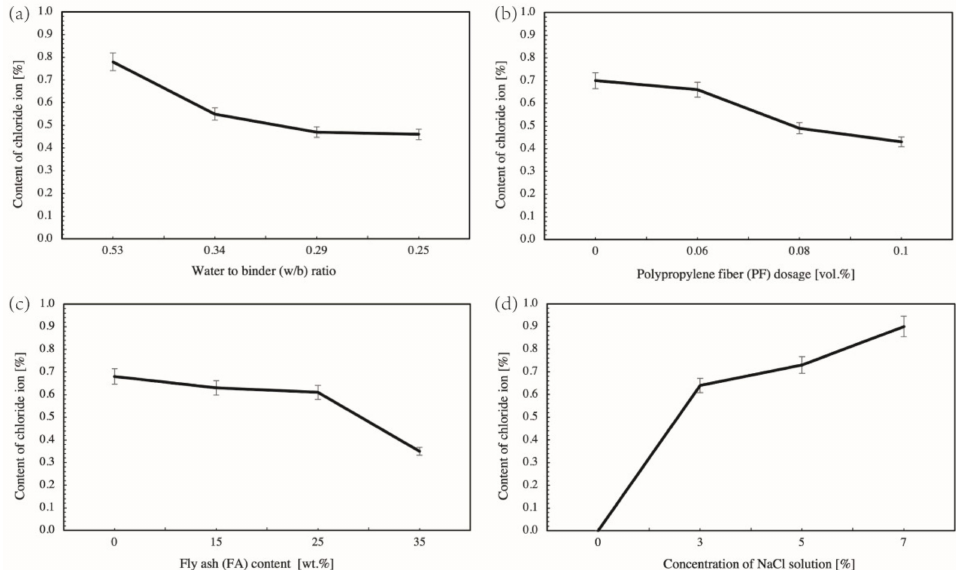
Figure 9. Influence of various factors on the content of chloride ions in 0–2 mm depth of concrete sam- ples suffered dry–wet cyclic immersion for 30 d. ( a ) Water to binder (w/b) ratio, ( b ) Polypropylene fiber (PF) dosage [vol.%], ( c ) Fly ash (FA) content [wt.%], ( d ) Concentration NaCl solution